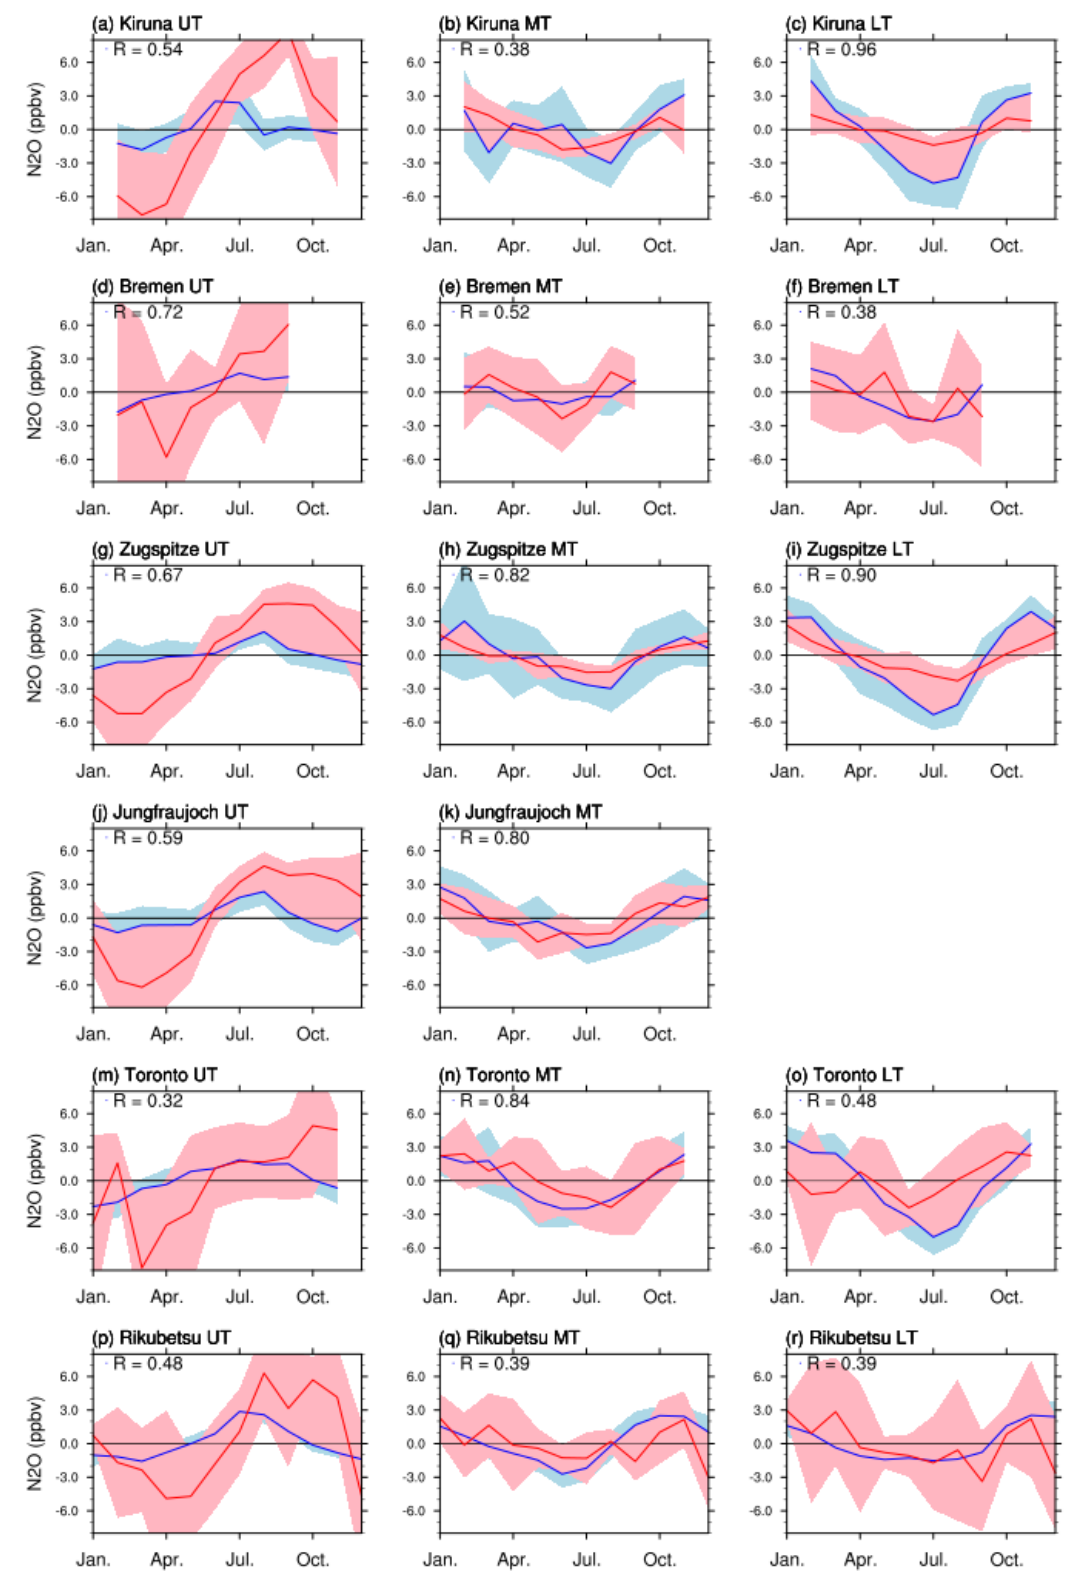
Figure 10. Seasonal cycles obtained from detrended FTIR (red) and SOFRID (blue) data at the 6 NH stations. The colored area represent the inter-annual variabilities for FTIR (light red) and SOFRID (light blue). There are no data for Jungfraujoch in the LT (missing panel l) because of the high altitude of the